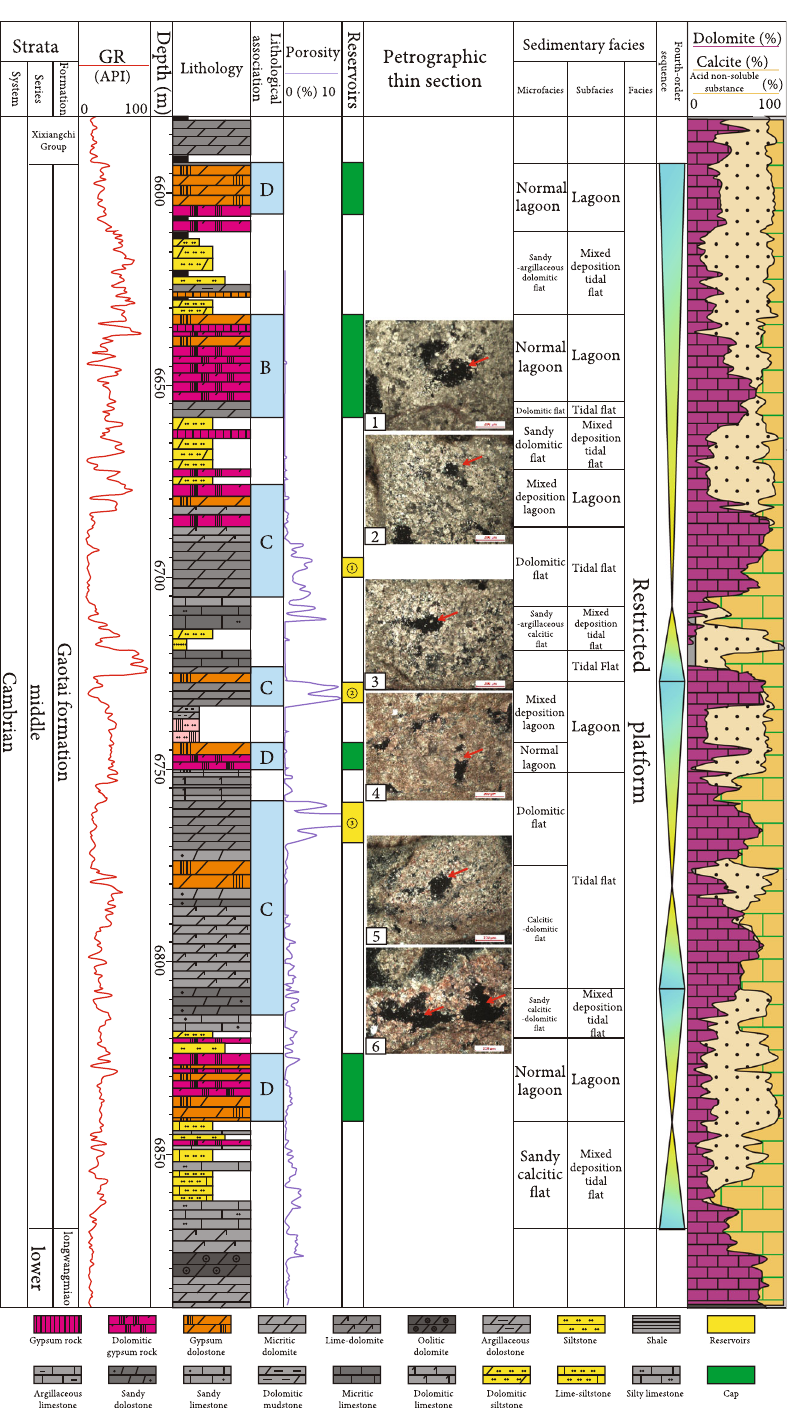
Figure 14: Comprehensive column chart of sedimentary reservoirs of the Gaotai Formation in Wutan 1 Well, Sichuan Basin. 1.6695 m, crystal powder dolomite, dissolved pores, dyed fl akes, 10 × 5(+); 2.6700m, crystal powder dolomite, dissolved pores, dyed fl akes, 10 × 5(+); 3.6729m, crystal powder dolomite, dissolved pores, dyed fl akes, 10 × 5(+); 4.6732 m, crystal powder dolomite, dissolved pores, dyed fl akes, 10 × 5(+); 5.6759m, crystal powder dolomite, dissolved pores, dyed fl akes, 10 × 5(+); 6.6762m, crystal powder dolomite, dissolved pores, dyed fl akes, 10 ×